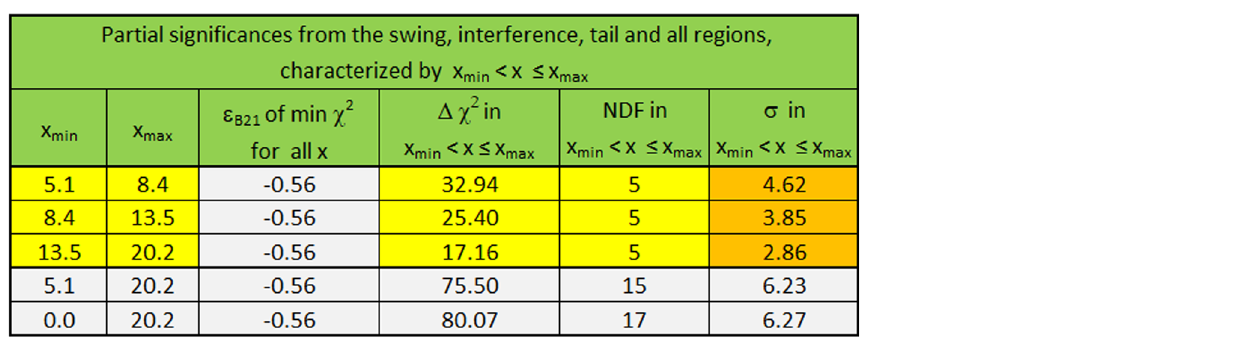
Table 11 Stability of the Odderon signal in various regions of x min and x max , for a constant value of the correlation coefficient (cid:13) b , 21 , minimized on all the 17 available D0 data points. In this case, the greatest partial contribution to the Odderon significance comes from the swing region,